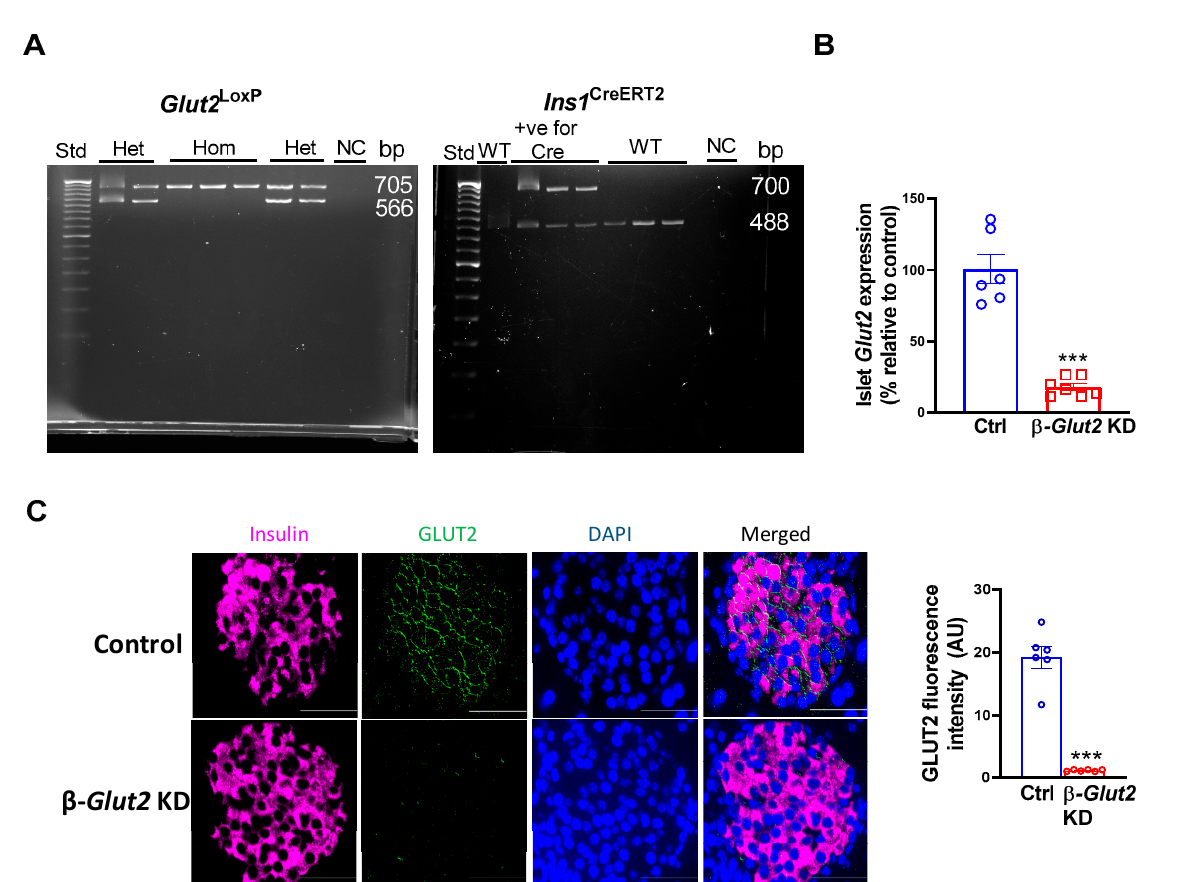
Figure 1. Generation and validation of β -cell Glut2 knockdown ( β - Glut2 KD) mice. Representative genotypes of mice used in this study ( A ). Het, heterozygous; Hom, homozygous for Glut2 loxP . Std, standard DNA ladder; NC, negative control; bp, base pair. Results from qRT-PCR showing knockdown of islet Glut2 in 8 weeks old male β - Glut2 KD mice one week after inducing β -cell Glut2 deficiency, n = 6 or 7 ( B ). Immunofluorescence demonstrating deficiency of β -cell GLUT2 in male β - Glut2 KD mice, n = 6 or 7 ( C ). Three islets per section and 3 sections per mouse were quantified ( C ). Scale bar is 50 µ m. Ctrl, control Glut2 loxP/loxP mice; AU, arbitrary unit. Student’s unpaired t -test was used for comparisons, *** p < 0.001. Error bars are mean ± SEM.